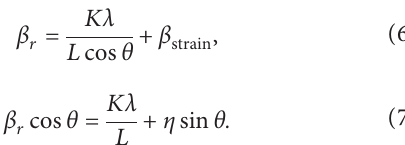
2 powder in this